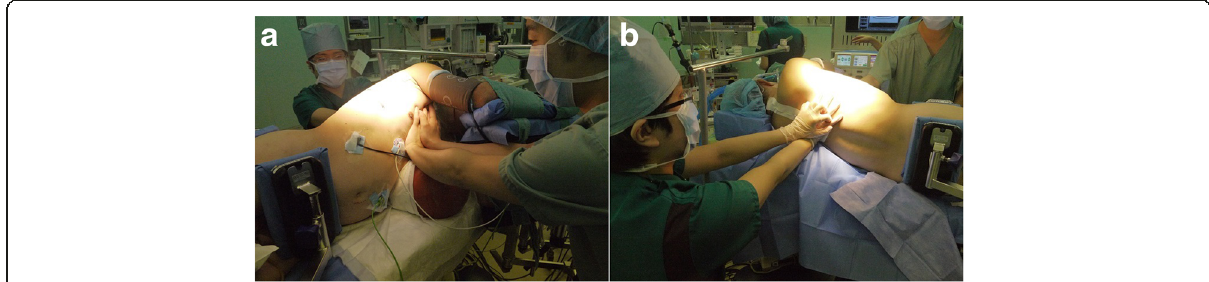
sternum. Picture ( b ) shows the other surgeon standing behind the patient and pushed his mid-thoracic spine. Chest compression was performed